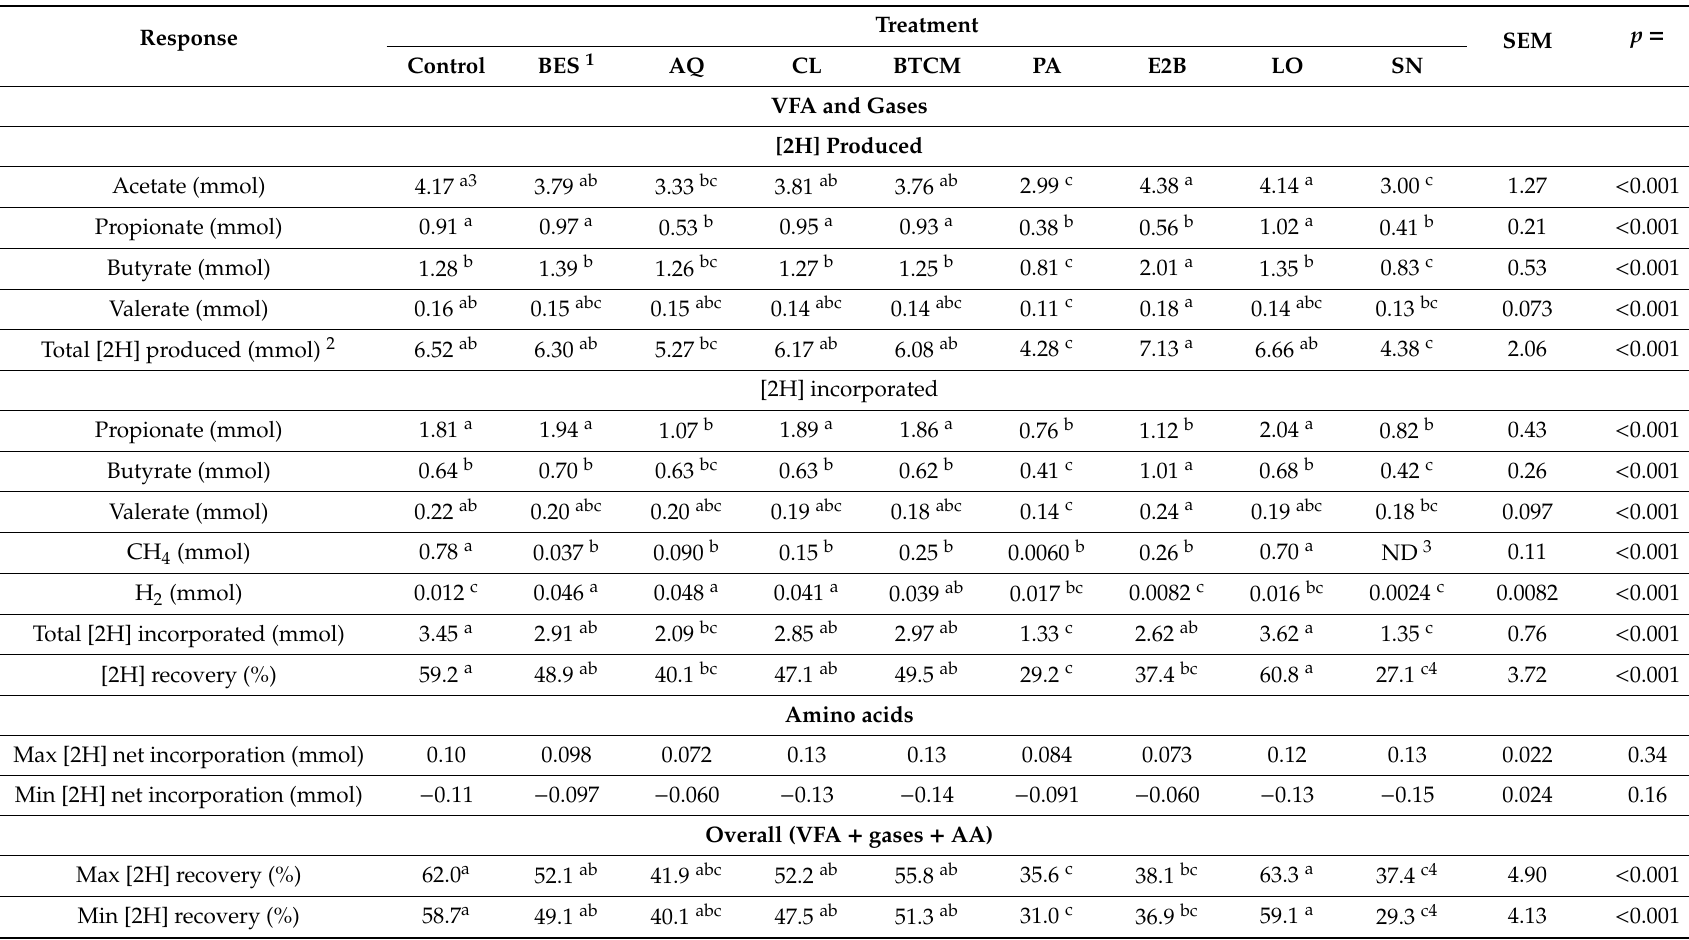
Table 3. E ff ects of several inhibitors of methanogenesis on the balance of reducing equivalents pairs ([2H]) in ruminal batch cultures.